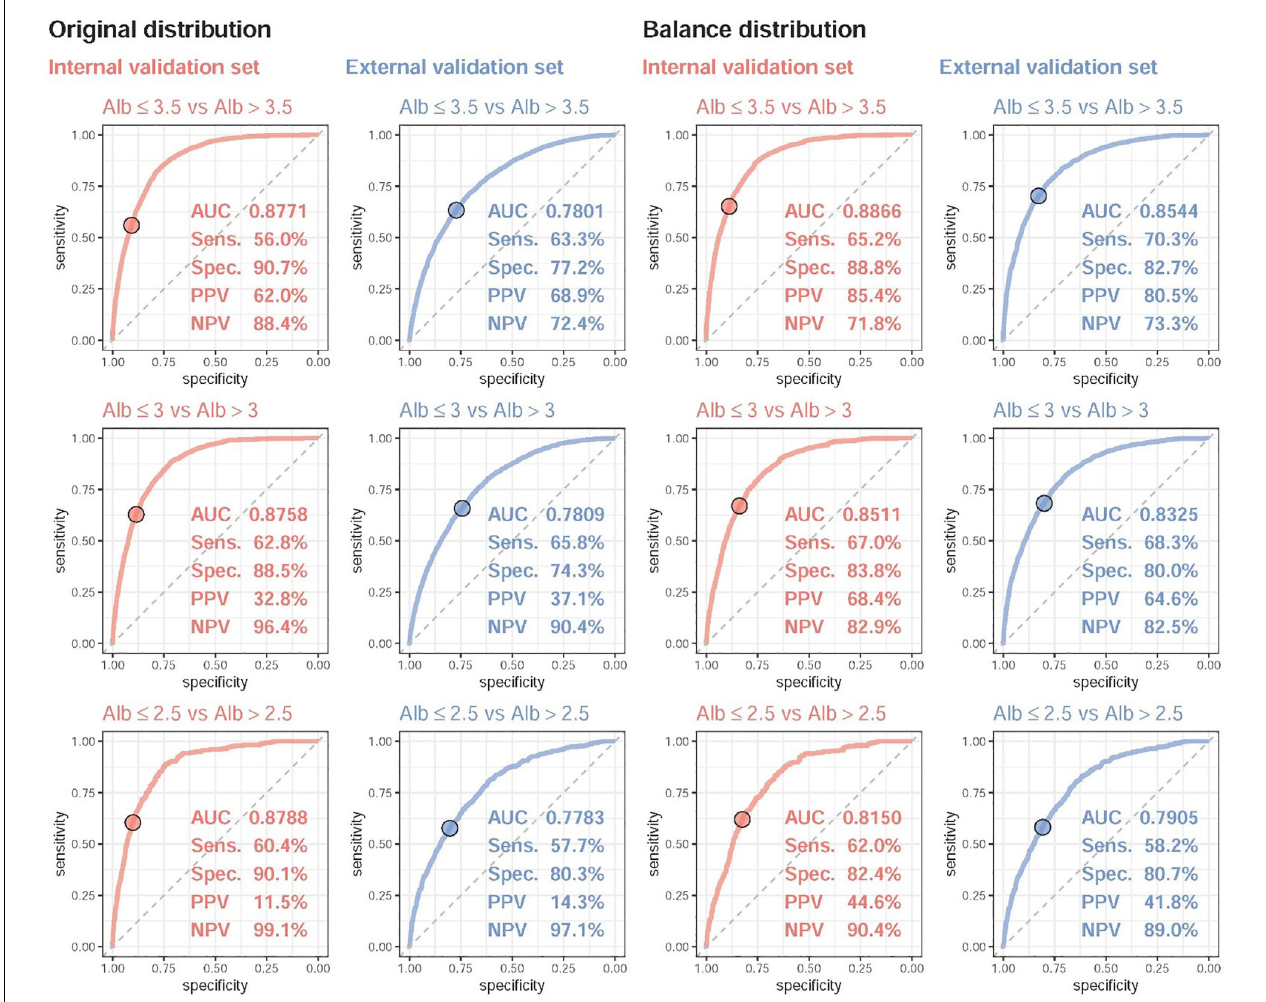
FIGURE 3 | The ROC curve of DLM predictions based on ECG to detect mild to severe hypoalbuminemia. Mild, moderate, and severe hypoalbuminemia were defined as an actual albumin (Alb) of ≤ 3.5, ≤ 3.0, and ≤ 2.5, respectively. The operating point was selected based on the maximum Youden’s index in the tuning set and presented using a circle mark, and the area under the ROC curve (AUC), sensitivity (Sens.), specificity (Spec.), positive predictive value (PPV), and negative predictive value (NPV) were calculated based on it. Due to the different distributions of Alb in the internal and external validation sets, we generated a balanced dataset for each set to ensure the same number of cases for different values of